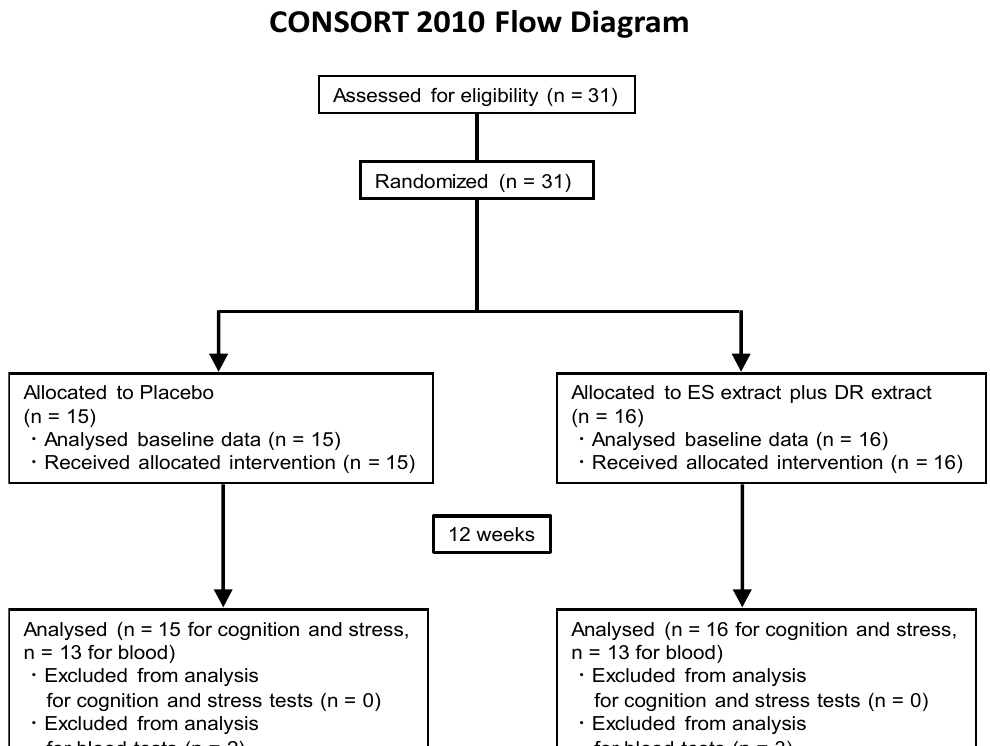
Figure 1. Study flow (CONSORT 2010 diagram). CONSORT, Consolidated Standards of Reporting Trials. Table 1. Sociodemographic and baseline characteristics of the sample.